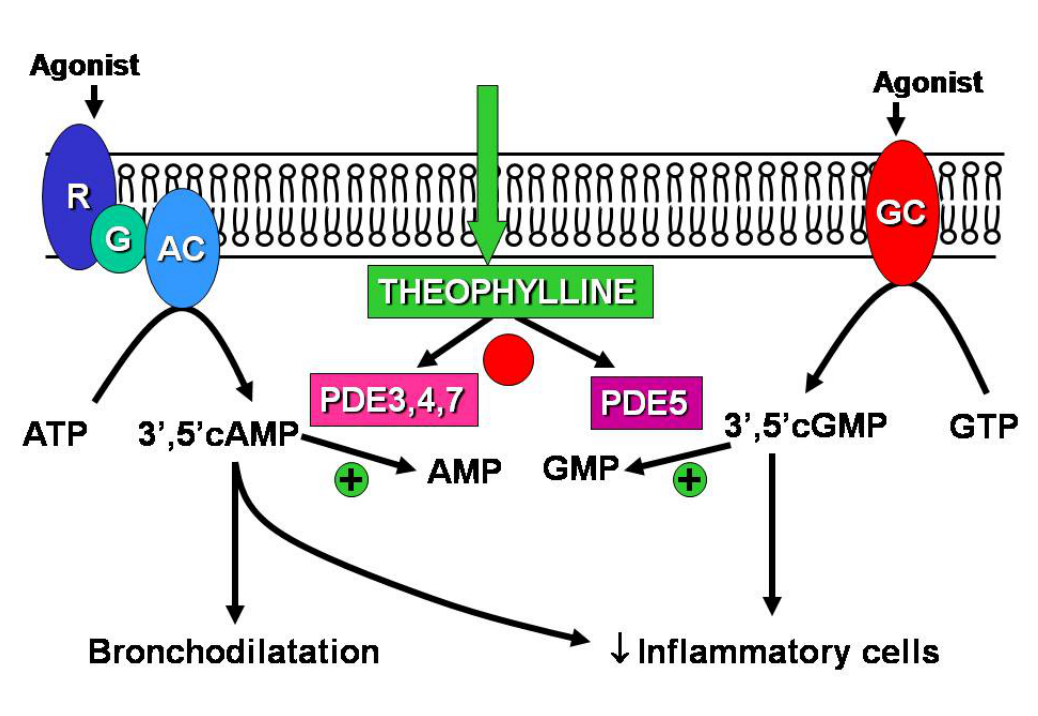
Figure 1. Effect of phosphodiesterase (PDE) inhibitors in the breakdown of cyclic nucleotides in airway smooth muscle and inflammatory